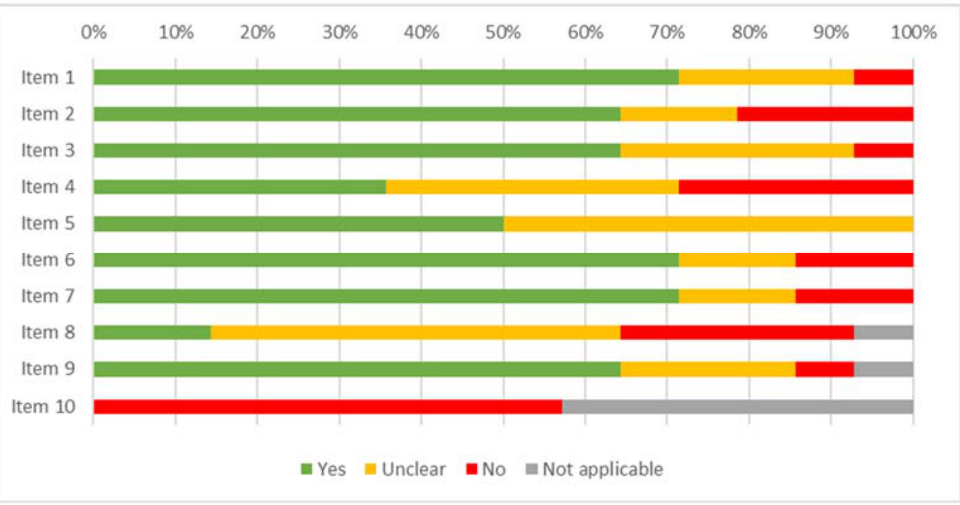
Figure 4. Summary of the critical appraisal process of the cohort studies according to the JBI tools [221a in Supplementary S3].